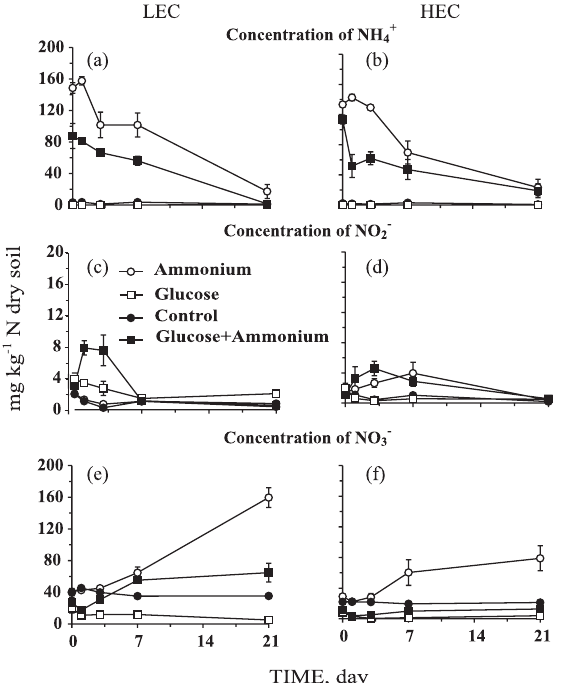
Figure 2. Concentration of NH 4+ in (a) LEC soil and (b) HEC soil, concentration of NO soil and (d) HEC soil and concentration of NO in (e) LEC soil and (f) HEC soil. Legends to the figure are given in figure 1.